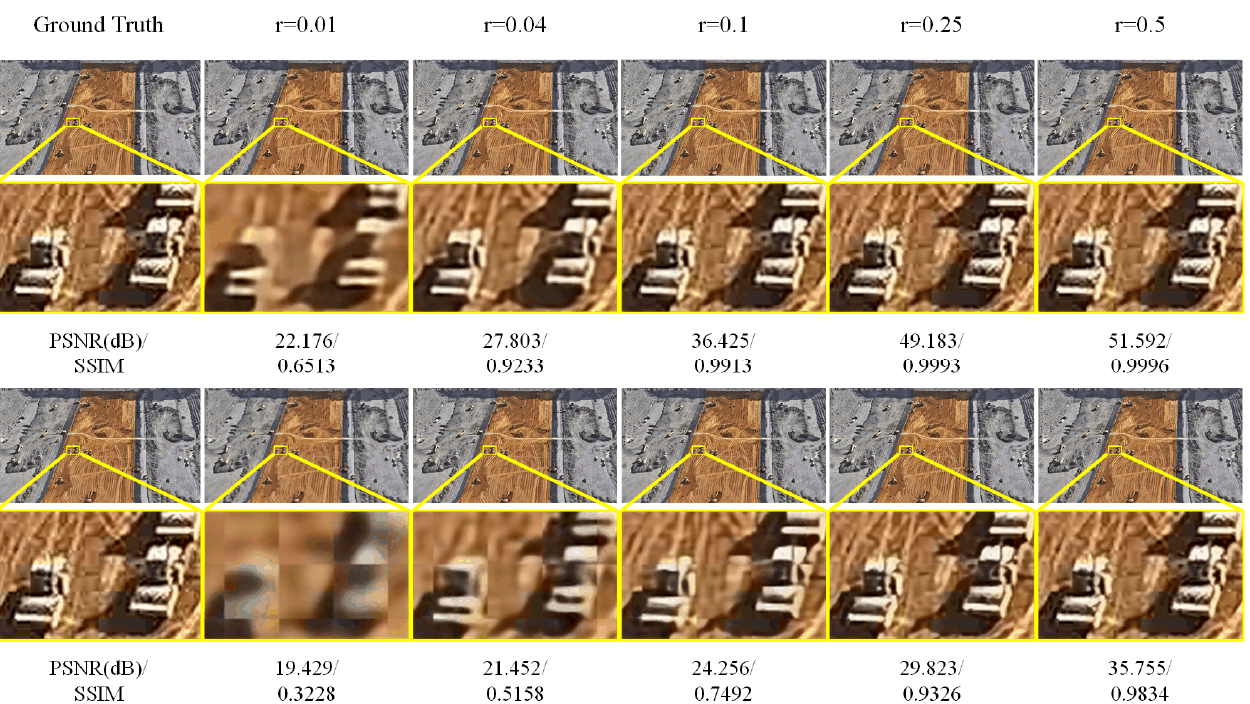
Figure 6. Visual quality comparison of large-scene construction site monitoring image CS recovery between CSNet + and EHDCS-Net at different CS ratios. The first row is images reconstructed by EHDCS-Net and the second row is images reconstructed by CSNet + .